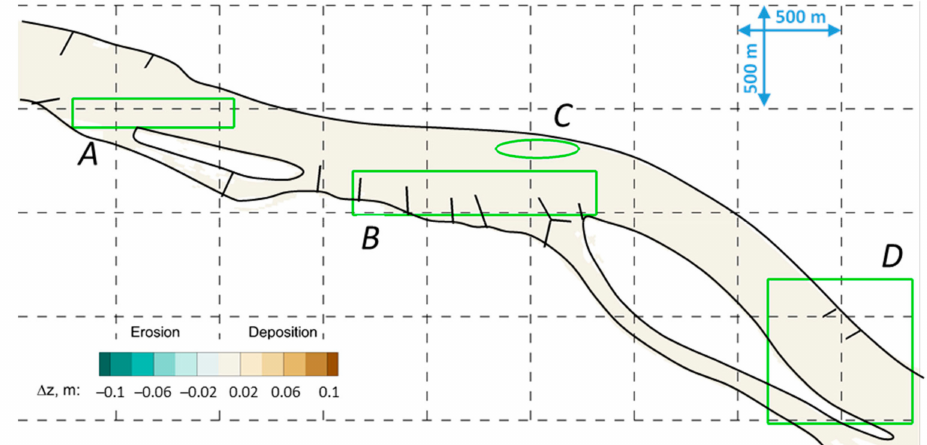
Figure 7. Calculated bed changes by the Wilcock and Crowe ( W&C ) formula for a 2.5 month-long period (Figure